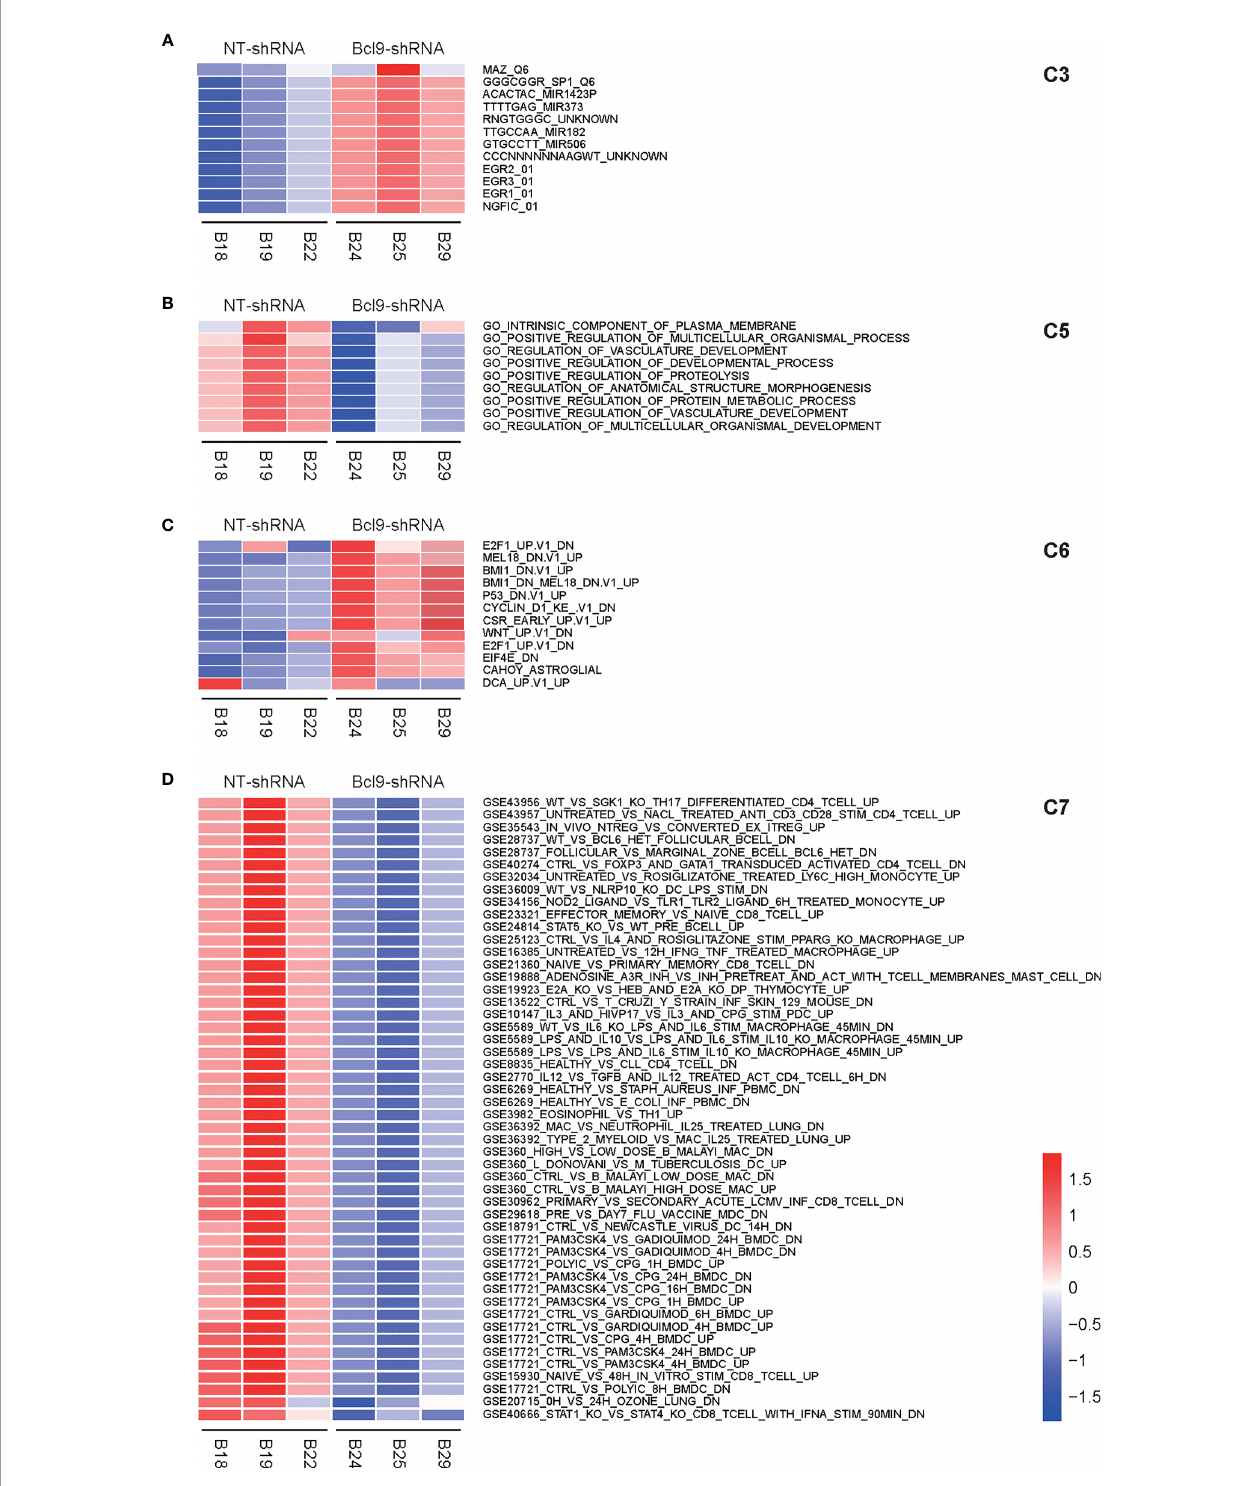
FIGURE 3 | GSVA analysis of CAF in mouse CT26 tumor. (A) Motif gene sets a direct comparison of tumor cells between NT group and Bcl9 knockdown group, revealing IK3 and IRF pathways as the enriched signatures in tumor cells. (B) Gene ontology relative regulation of vasculature development gene is the enriched signature in NT tumor cells. (C) Oncogenic signatures manifest PDG, MTOR, and PETEN pathways as the enriched signatures in NT tumor cells. (D) Immunologic signatures pathway, such as TGF, is the enriched signature in tumor